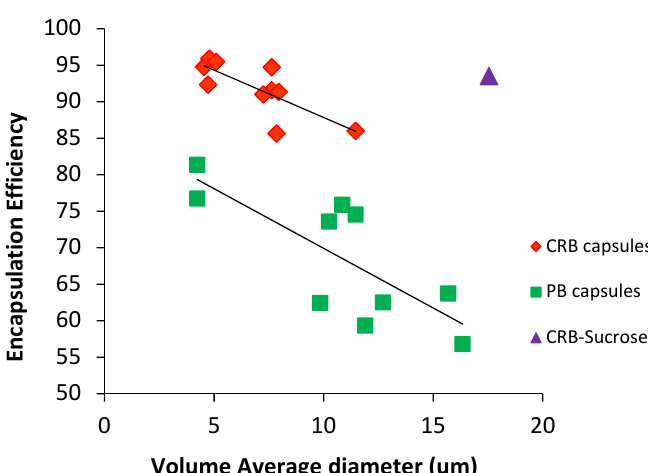
Figure 12. Linear tendency of increasing encapsulation efficiency as a result of decreasing average volume diameter of colorant particles. Each of the encapsulated system replicas was graph against their encapsulation efficiency. Two parallel tendencies are observed: ♦ CRB microcapsules and ■ PB microcapsules.